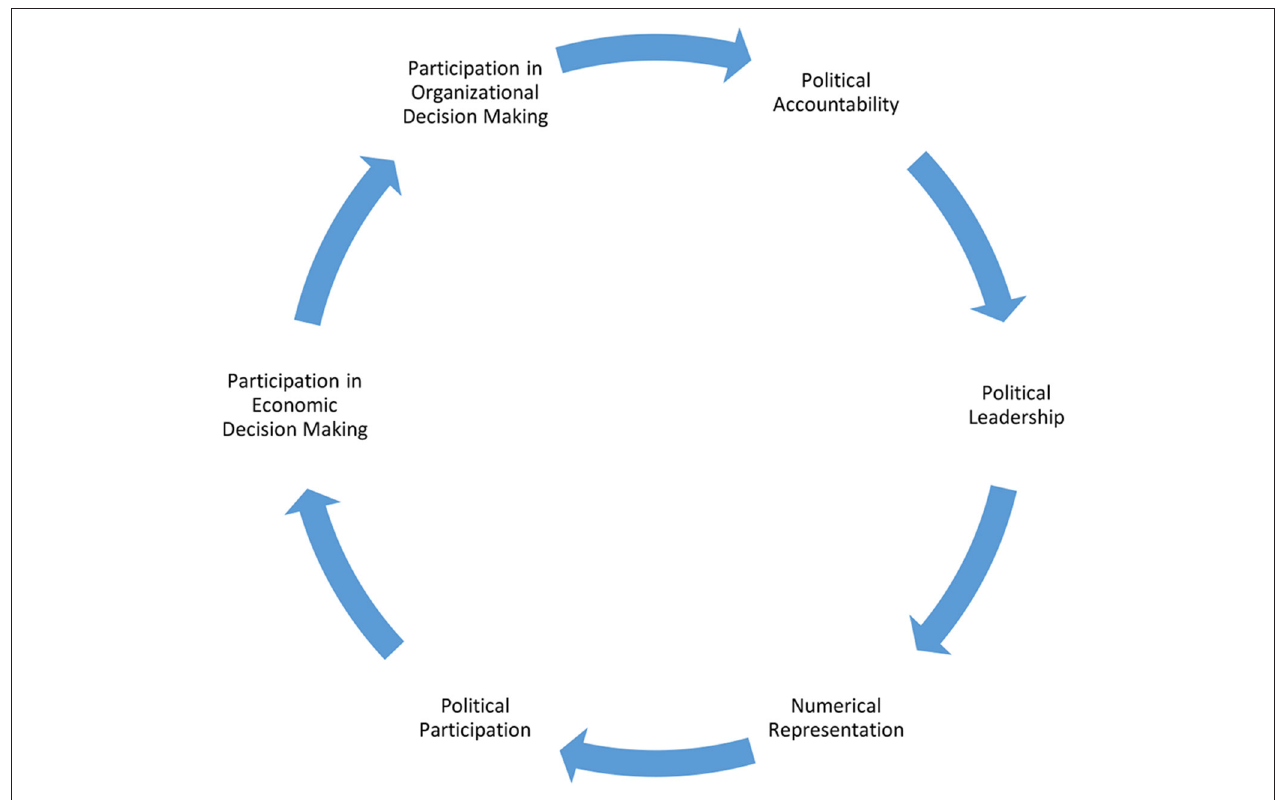
FIGURE 1 | Women’s empowerment and involvement in